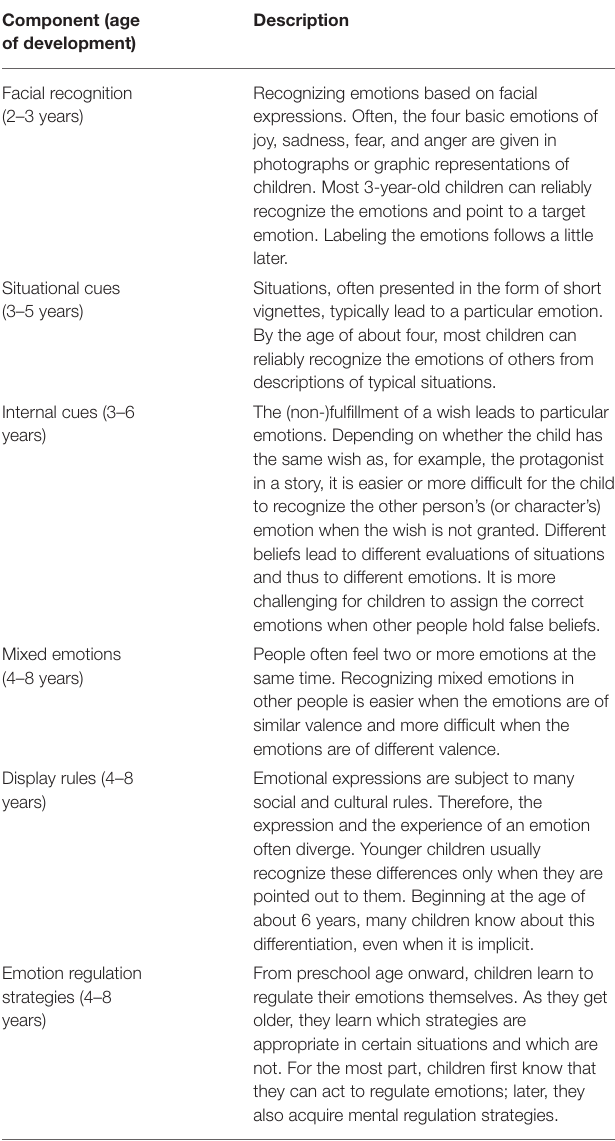
TABLE 1 | Overview of emotion knowledge components and their development in early childhood. Component (age of